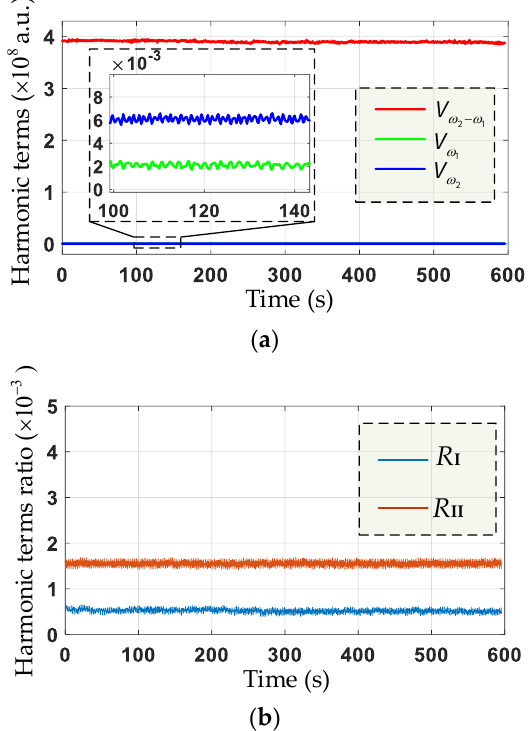
Figure 3. Digital phase-lock result of modulation signals: ( a ) amplitude of harmonic terms; ( b ) ratio of harmonic terms.